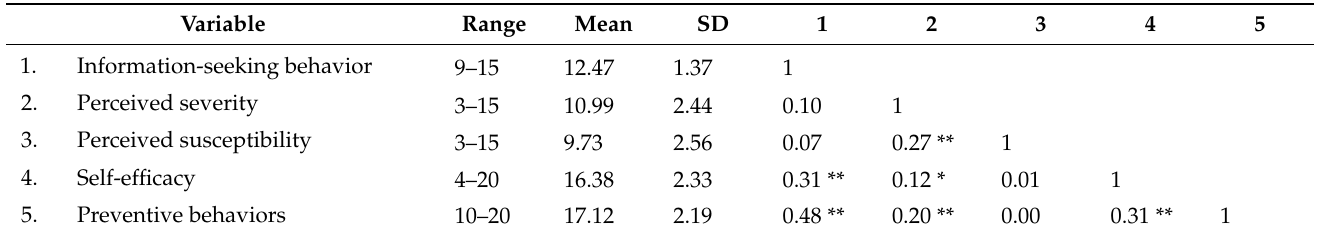
Table 3. Correlation analysis variables.